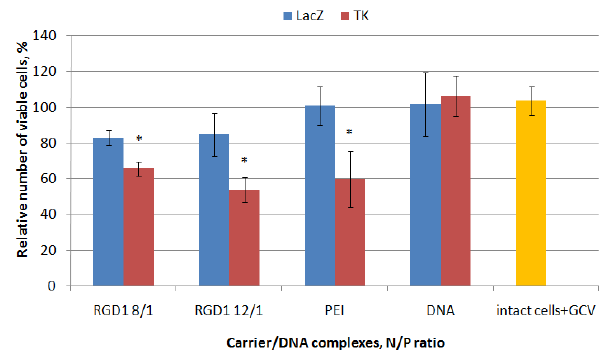
Figure 9. Thymidine kinase-driven suicide gene therapy in vitro: the PANC-1 cell line was transfected